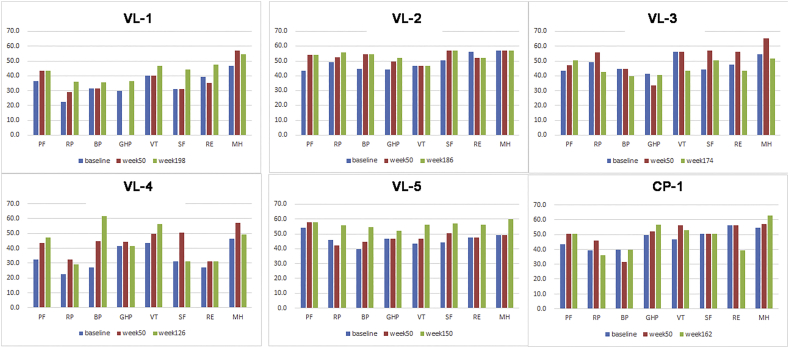
Quality of life evaluation in each patient.Color bars indicate the clinical value: SF-36 scores at baseline, week 50, and at the last survey point, respectively.PF, physical functioning; RP, role limitation due to physical problems; BP, bodily pain; GHP, general health perception; VT, vitality; SF, social functioning; RE, role limitation due to emotional problems; MH, mental health.